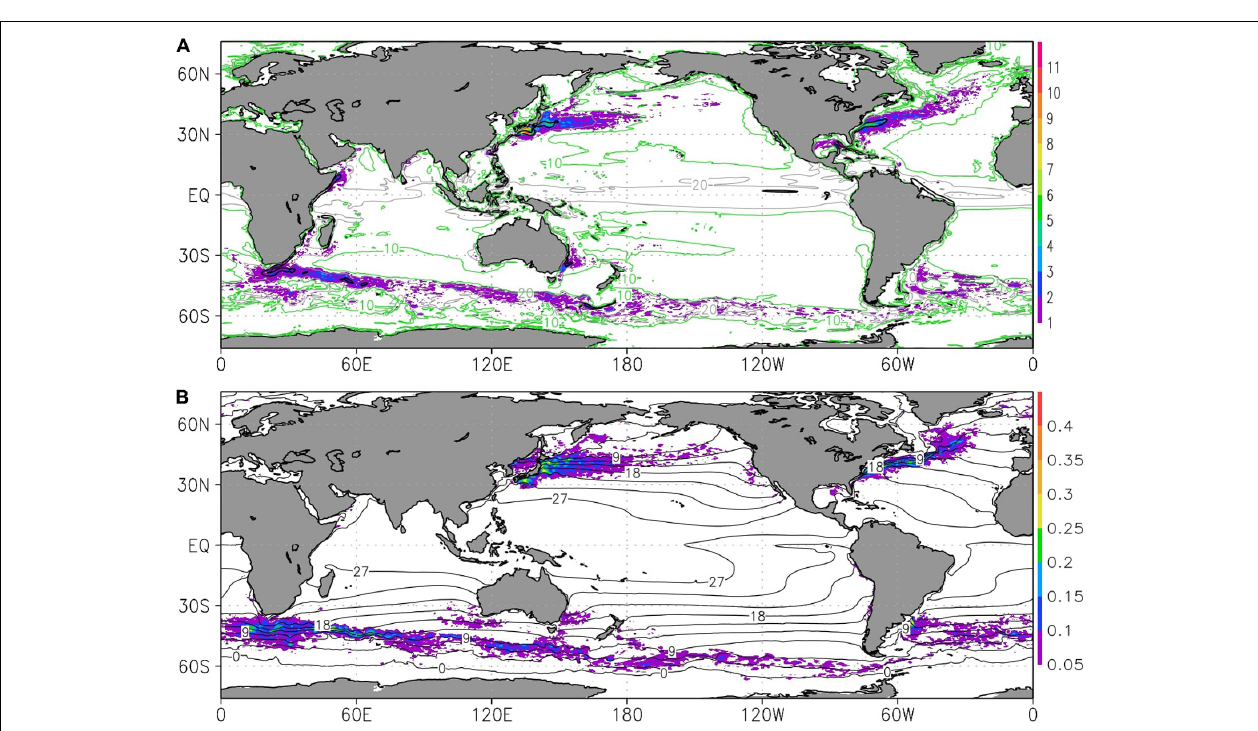
FIGURE 1 | Global map of the long-term (1986–2015) mean (A) surface (2.5-m depth) current speed, and (B) SST. Contours (shadings) indicate the ensemble mean (spread). Contour intervals are 10 cm s − 1 (3 ◦ C) for (A,B) panel. Unit for the current speed is cm s − 1 , for SST ◦ C.